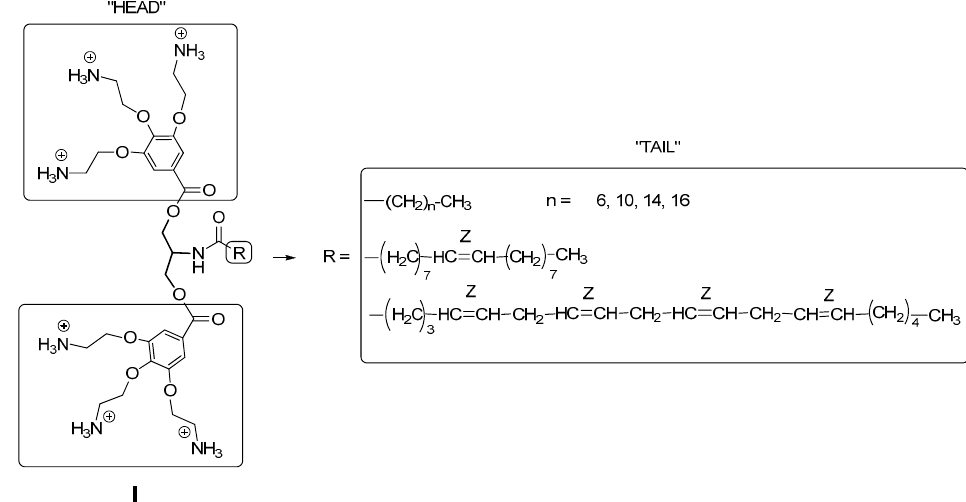
Figure 1. General structure of the synthesized compounds.